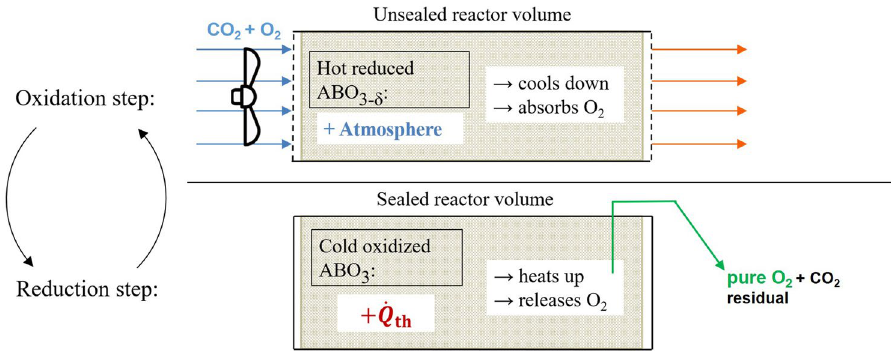
Figure 1. Visualization of the operating principle of the POP system. The oxidation step is carried out in an unsealed reactor, which leads to cooling of the perovskite with simultaneous oxidation of it. The reactor is then sealed, the temperature rises due to radioactive decay and oxygen is released as a result.